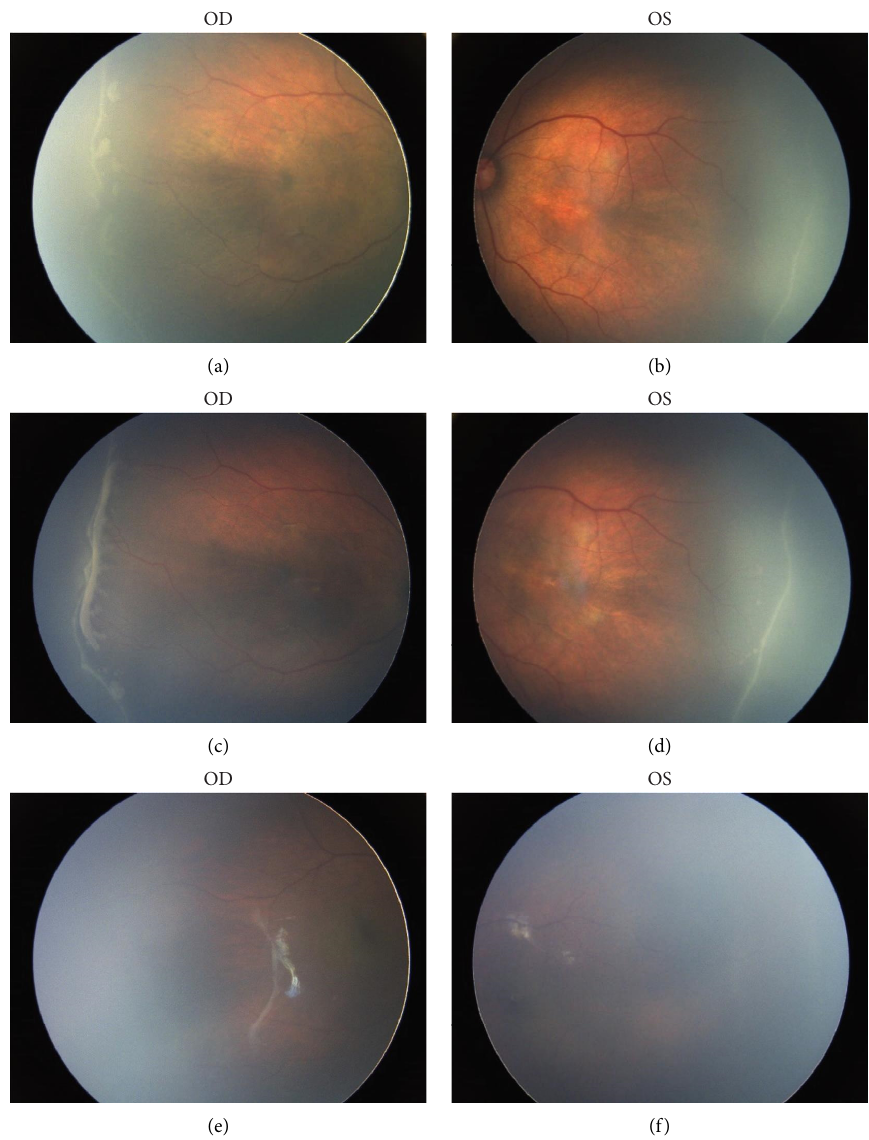
Figure 1: Nontype 1 ROP eyes considered to be treated due to multiple reasons. Case no. 3, male, GA 30w, BW 1.3kg. ROP in zone II, stage 2 with plus ( − ) in both the eyes was transferred to examination in PMA 39.1w (a, b). After 2 weeks (PMA 41.1w), the temporal ridge was thickened and widened with preplus in the right eye, which was ROP in zone II, stage 3 with preplus (c). As the contralateral eye, the ridge was more obvious and extended, which was still ROP in zone II, stage 2 with plus ( − ) (d). Te bilateral retinal vessels grew to the periphery of zone III at 27.9 weeks (PMA 69.0w) after intravitreal injection of conbercept (e,